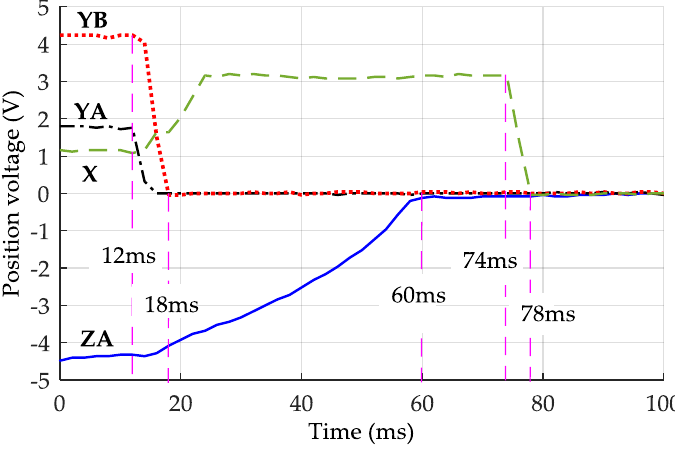
Figure 6. Measured time responses of four position sensing channels during initial lift-up of the PM.